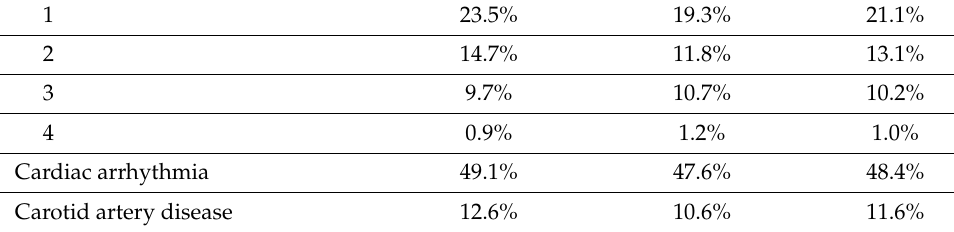
Table 2. Procedural characteristics.